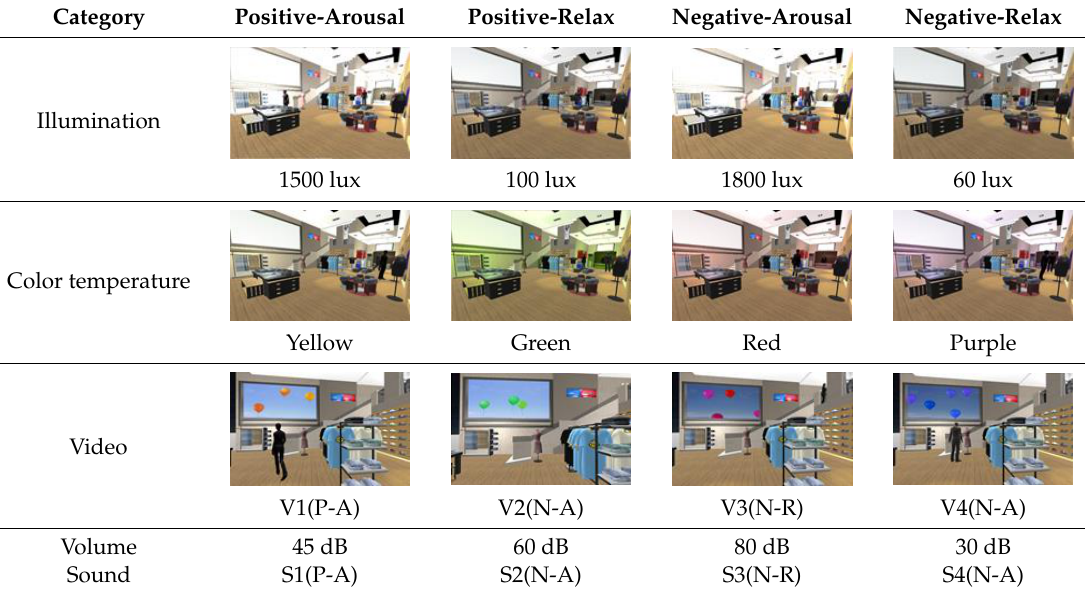
Table 6. Environmental stimuli of the virtual-physical space.